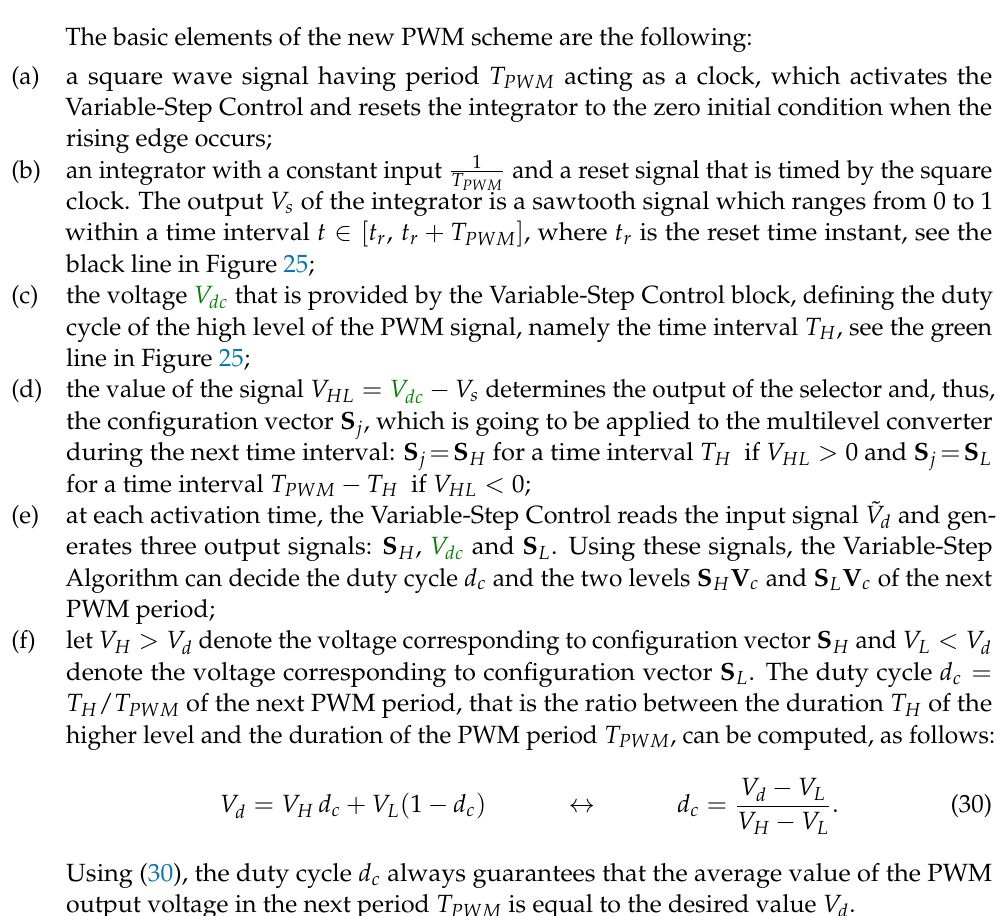
Figure 25. Scheme for the application of the configuration vectors S j higher and lower level time intervals T H and T PWM